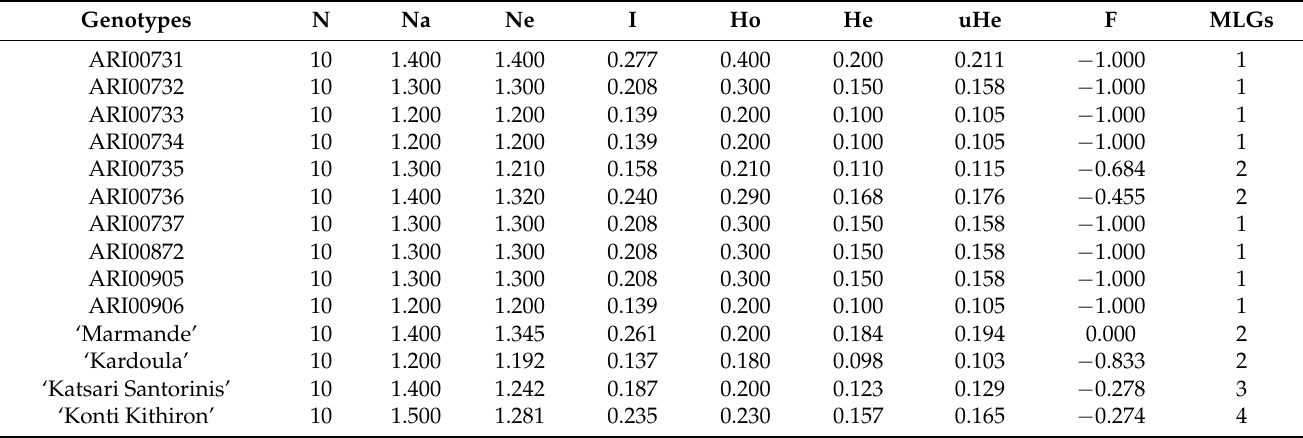
Table 2. Genetic diversity of landraces and heirloom varieties across the analyzed